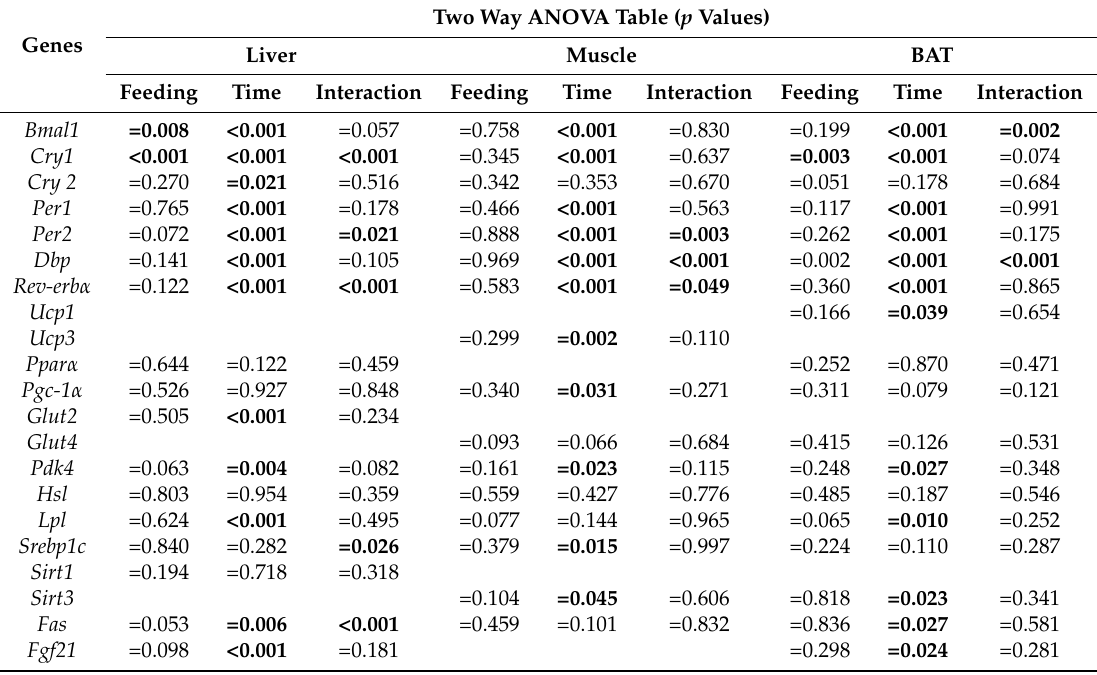
Table 1. Two-way ANOVA p values for the effect of feeding, time and interaction for the ad libitum and 6-meal feeding in liver, Muscle and BAT. Significant effects are indicated in bold.